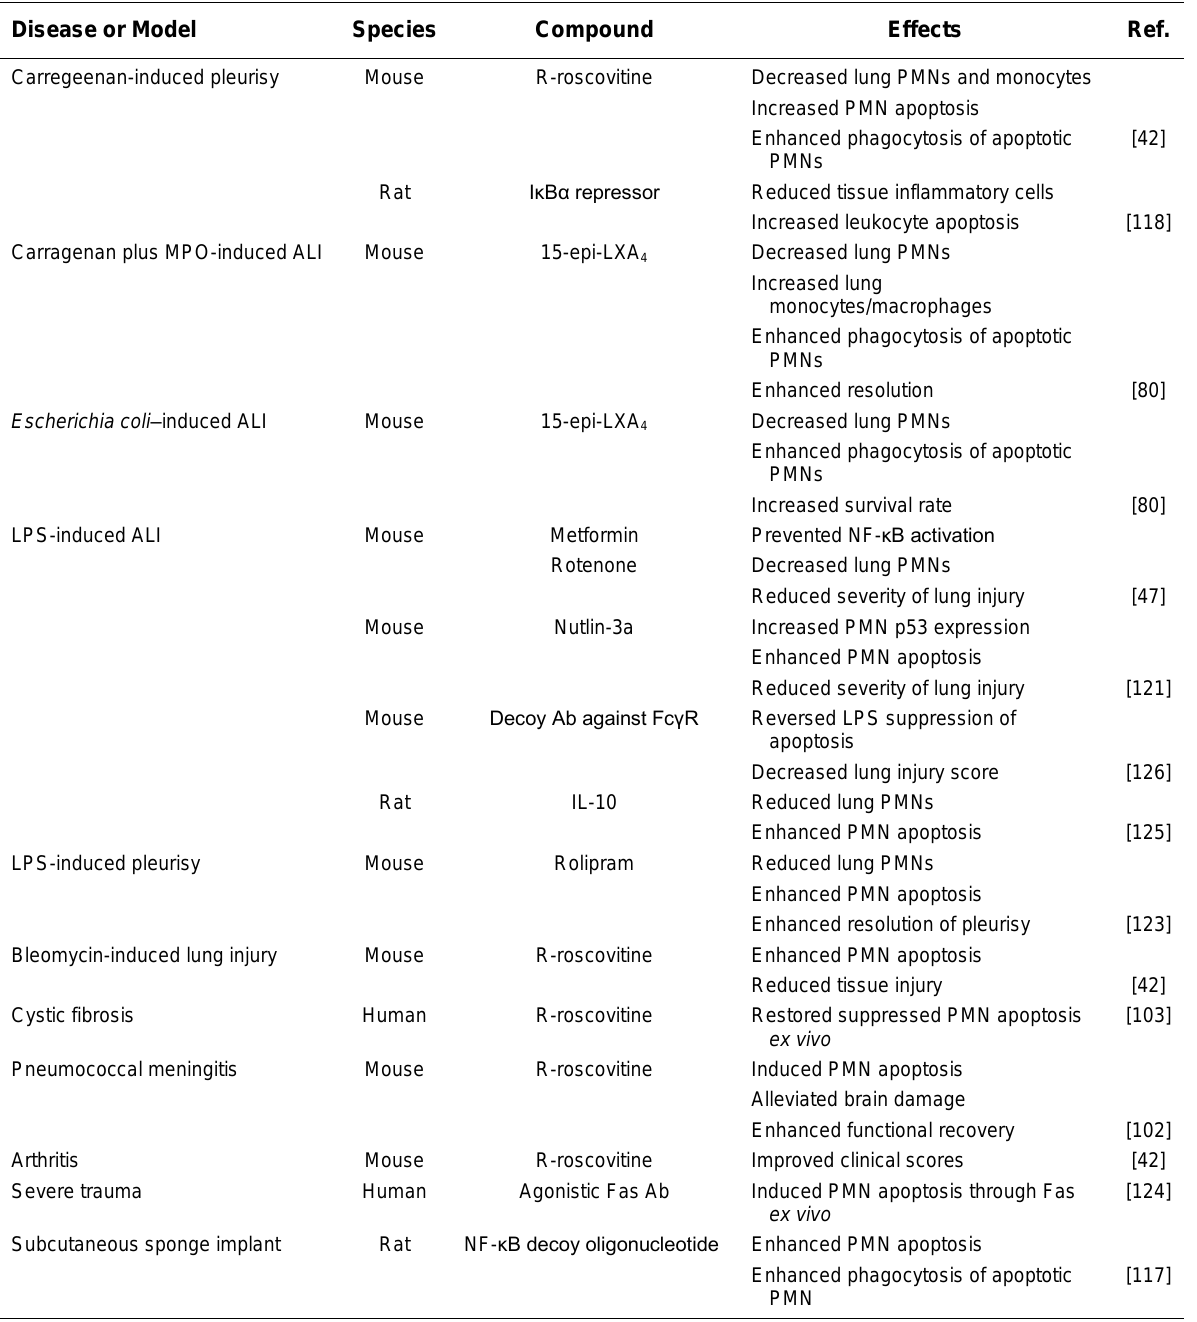
Therapeutic Induction of Neutrophil Apoptosis for Resolving Inflammation Disease or